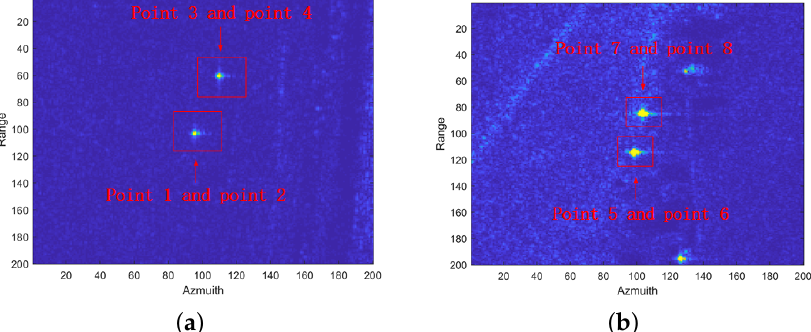
Figure 13. Four groups layover points. ( a ) On the 96th and 110th grids are the 0.5 m and 1 m layover points. ( b ) On the 98th and 104th grids are 1 m and 1 m layover